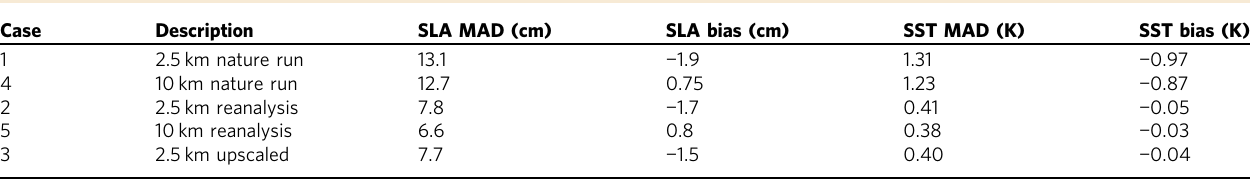
Table 1 Average forecast innovation statistics for 2006 – 2008 in the Tasman Sea region